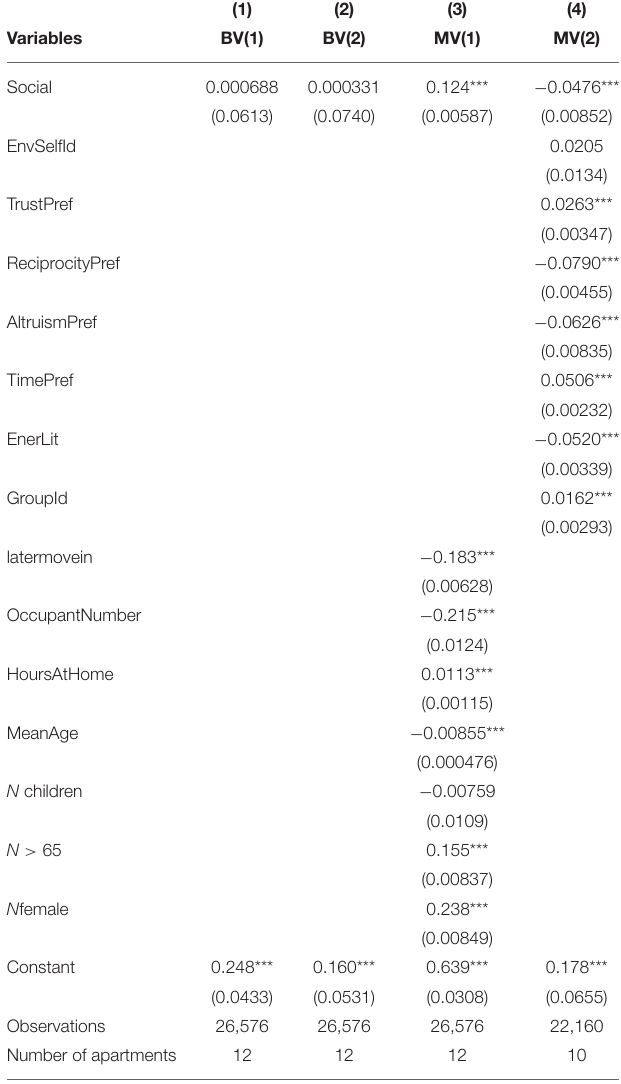
TABLE 4 | Results from GLS random effects